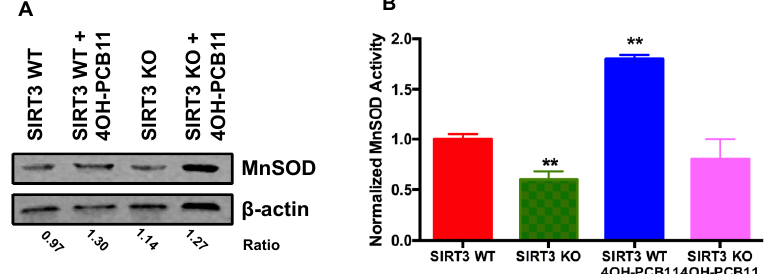
Figure 3. MnSOD activity was induced only in 4OH-PCB11-treated WT MEFs. ( A ) Asynchronous cultures of WT and SIRT3-KO MEFs were incubated with 3 μM 4OH-PCB11 for 24 h. Cells were harvested, scraped, and pelleted in PBS and lysed in radioimmunoprecipitation assay (RIPA) buffer for western blot. Quantitation was presented as the average ratio of MnSOD to β-actin in fluorescence units obtained from two different blots ( B ) To measure MnSOD activity, whole cell homogenates were prepared from the pellets and resuspended in 50 mM potassium phosphate buffer (pH 7.8) for spectrophotometric analysis. Data were normalized from two independent experiments. Data represent the mean of each group ± 1SEM ( n = 6). ** p < 0.01 as compared to vehicle-treated WT control